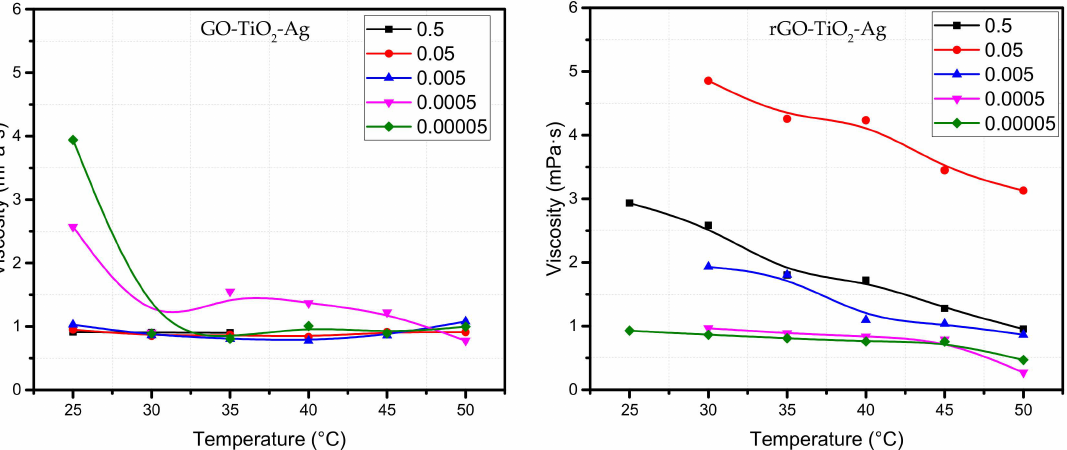
Figure 4. Viscosity vs. temperature at different temperatures and concentrations of ternary hybrid